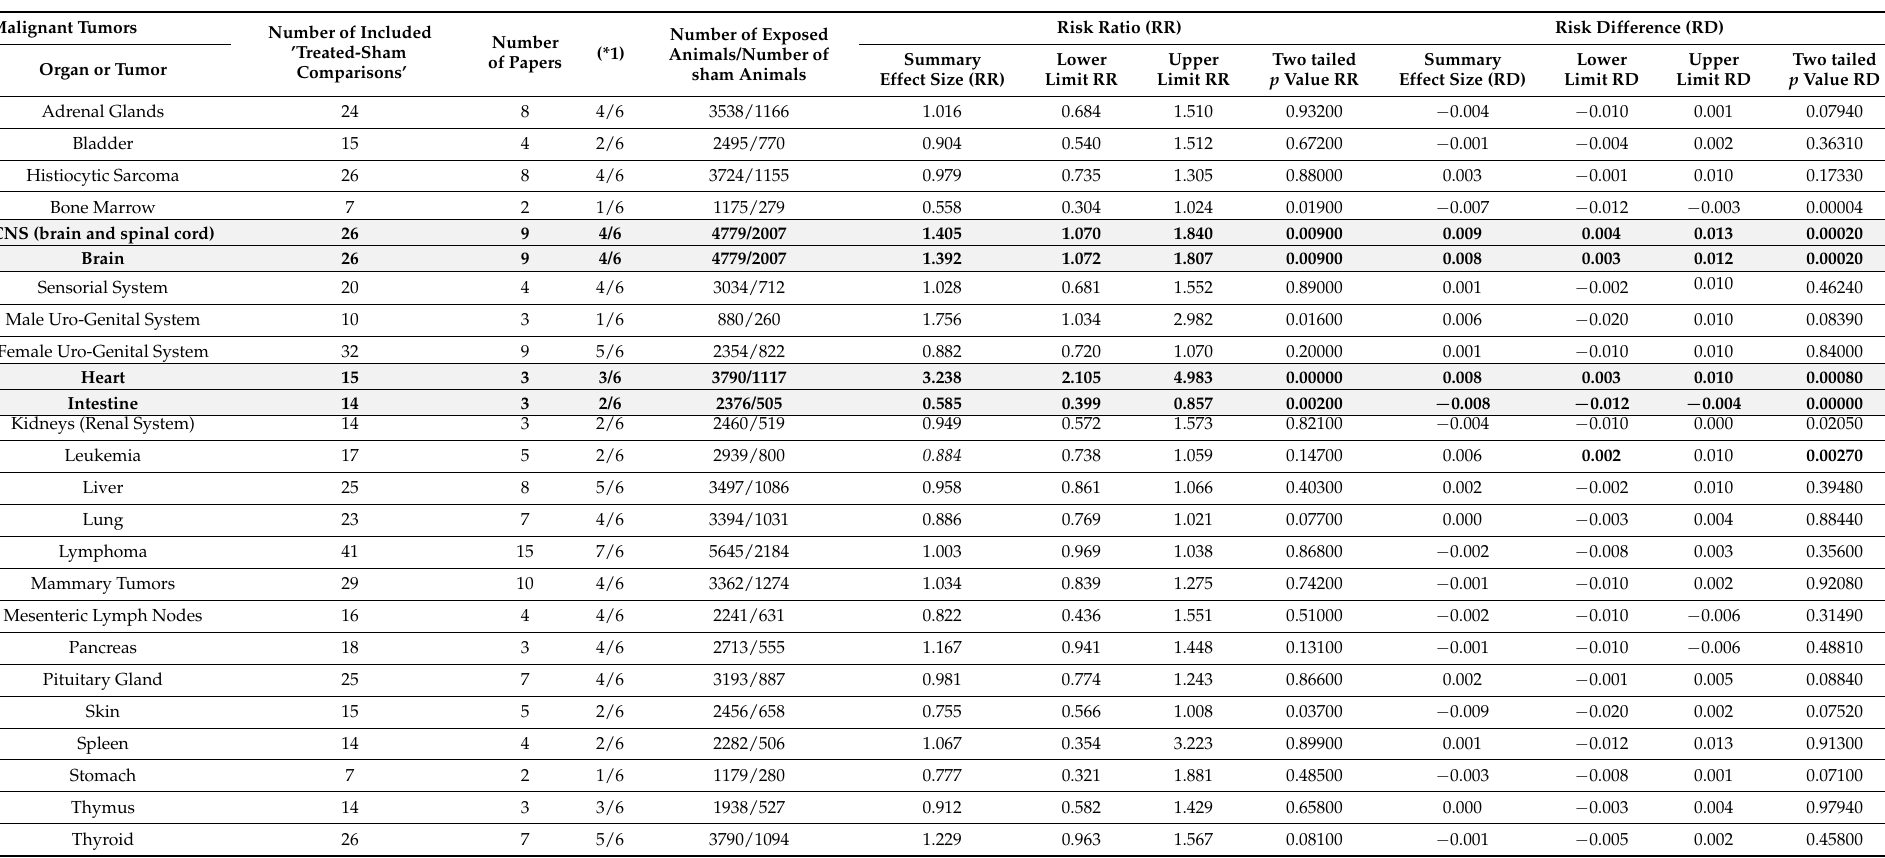
Table 3. Summary table of meta-analysis results carried out by “organ/malignant tumor”: for each sample both RR and RD with the relative limits of variability (CI 95%) and p -value are reported. Statistically significant results are highlighted in